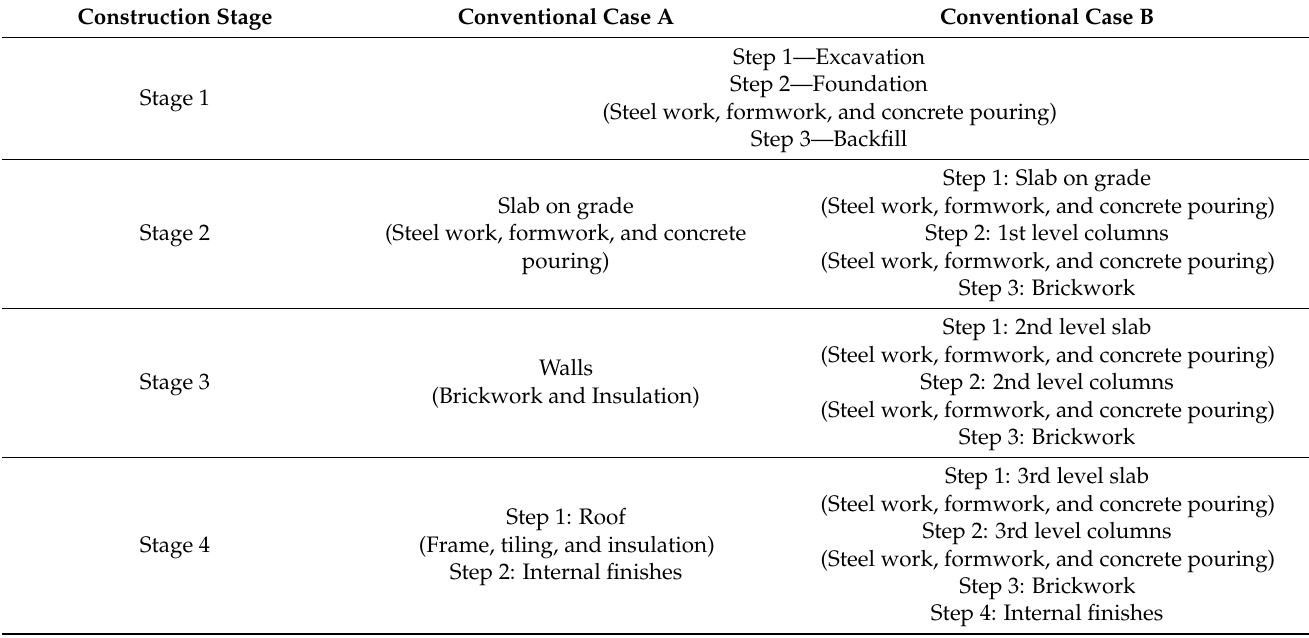
Figure 2. Floor plans of Case A : a granny flat with 63 m 2 area; and Case B : a three-story school with 740 m 2 per storey. Table 3. Construction stages for conventional Case A and conventional Case